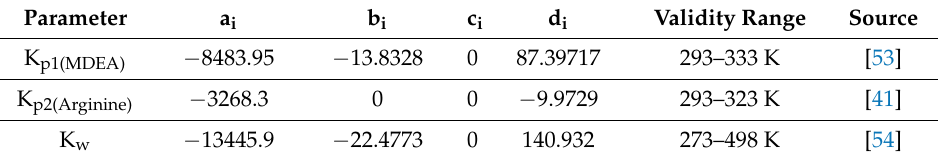
Table 3. Values of different equilibrium constant used to estimate OH − in Equation (20).